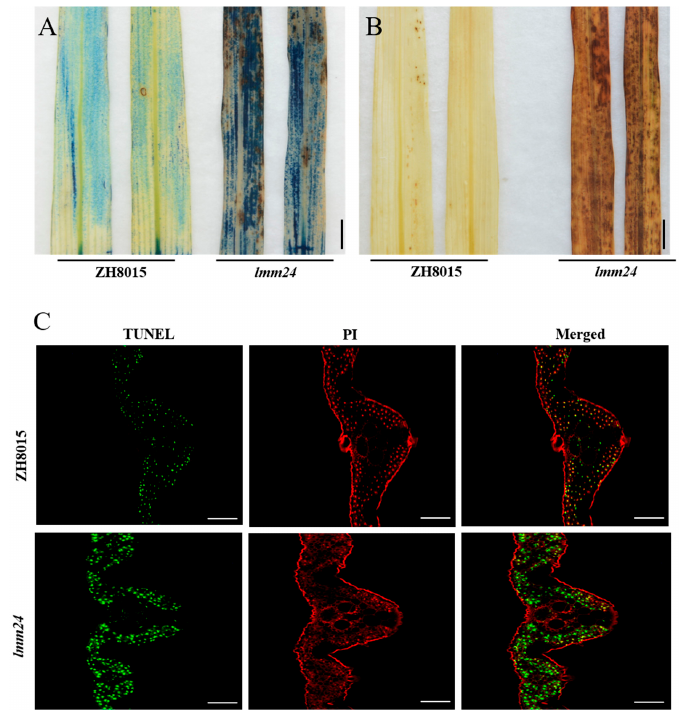
Figure 2. H 2 O 2 accumulation and cell death detection in ZH8015 and lmm24 . ( A ) Evans blue staining for cell death. ( B ) Diaminobenzidine (DAB) staining for H 2 O 2 accumulation. ( C ) DNA fragmentation